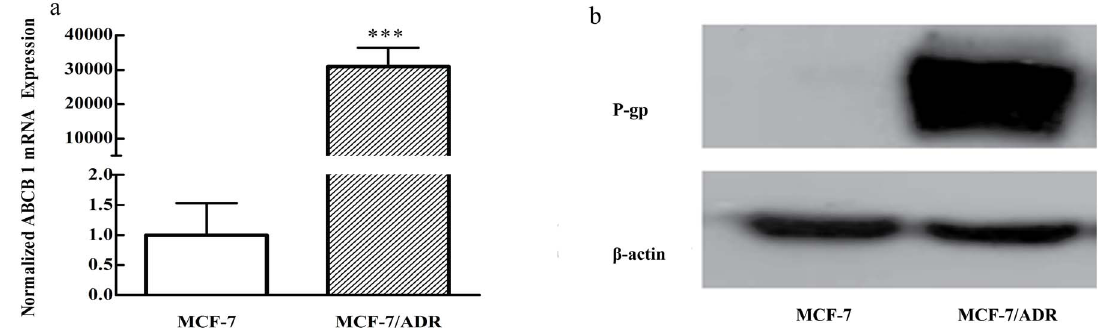
Figure 2. P-gp overexpression in MCF-7/ADR cell lines. a: ABCB-1 expression level in MCF-7 vs. MCF-7/ADR cells by real-time PCR b: P-gp expression level in MCF-7 vs. MCF-7/ADR cells by Western blotting *** P , 0.001 versus the parental cells.